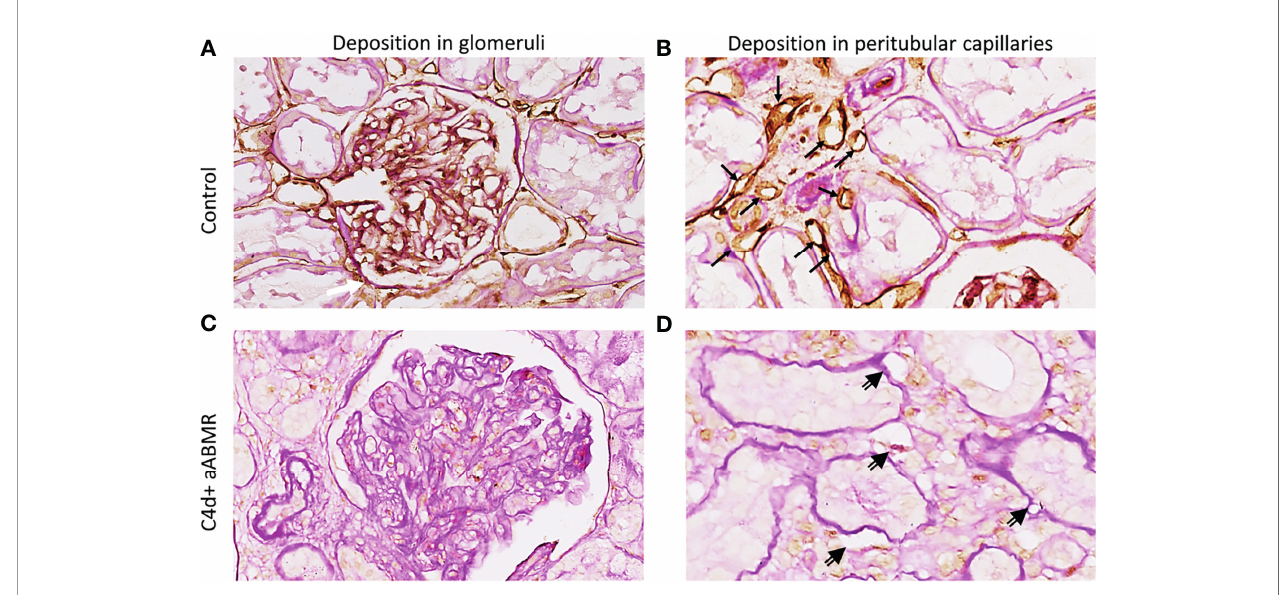
FIGURE 7 | CD59 staining in vivo . Renal biopsy staining for complement regulator CD59 in glomeruli (A, C) and peritubular capillaries (B, D) . Staining was performed on human kidney before transplantation as control (A, B) , on biopsy specimen from a C4d-positive (C4d+) aABMR (C, D) . Black arrows point to CD59- positive peritubular capillaries, double-compound arrows to CD59-negative peritubular capillaries. aABMR, active antibody-mediated rejection.